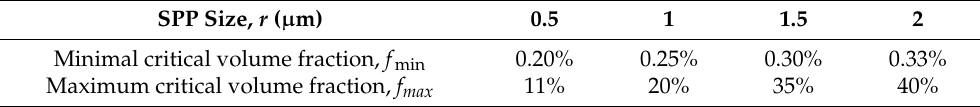
Figure 7. Variation in the average grain size curve as a function of time under different volume fractions of the SPP: ( a ) r = 0.5 µ m, ( b ) r = 1.0 µ m, ( c ) r = 1.5 µ m, and ( d ) r = 2.0 µ m. Table 1. Comparison of the critical volume fractions for different second-phase particle sizes.